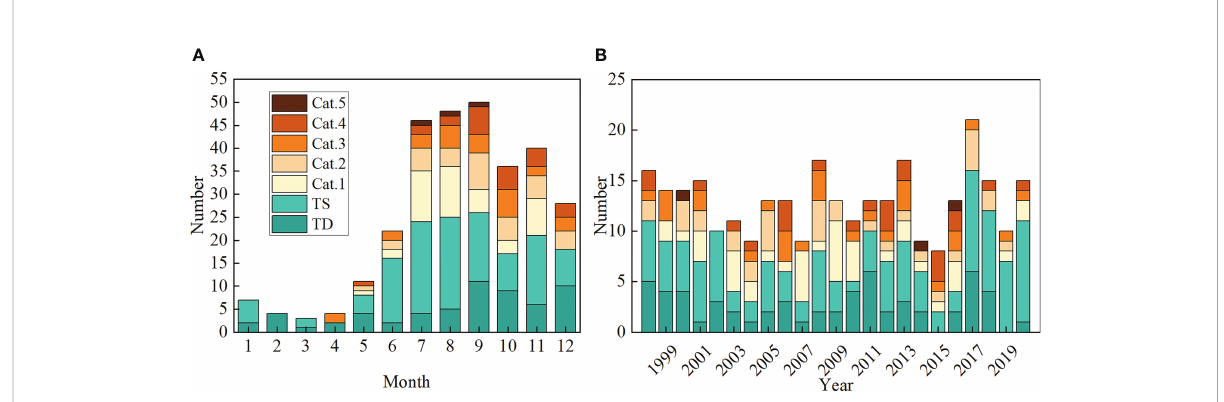
FIGURE 4 Statistics of TCs in the South China Sea between 1998 and 2020: (A) monthly and (B) annual number of TC events classi fi ed by the Saf fi r-Simpson Hurricane Wind